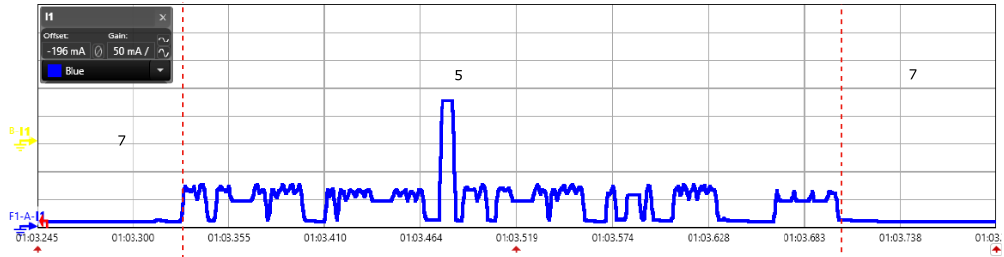
Figure 20. Scope view of a NB-IoT data transmission and deep